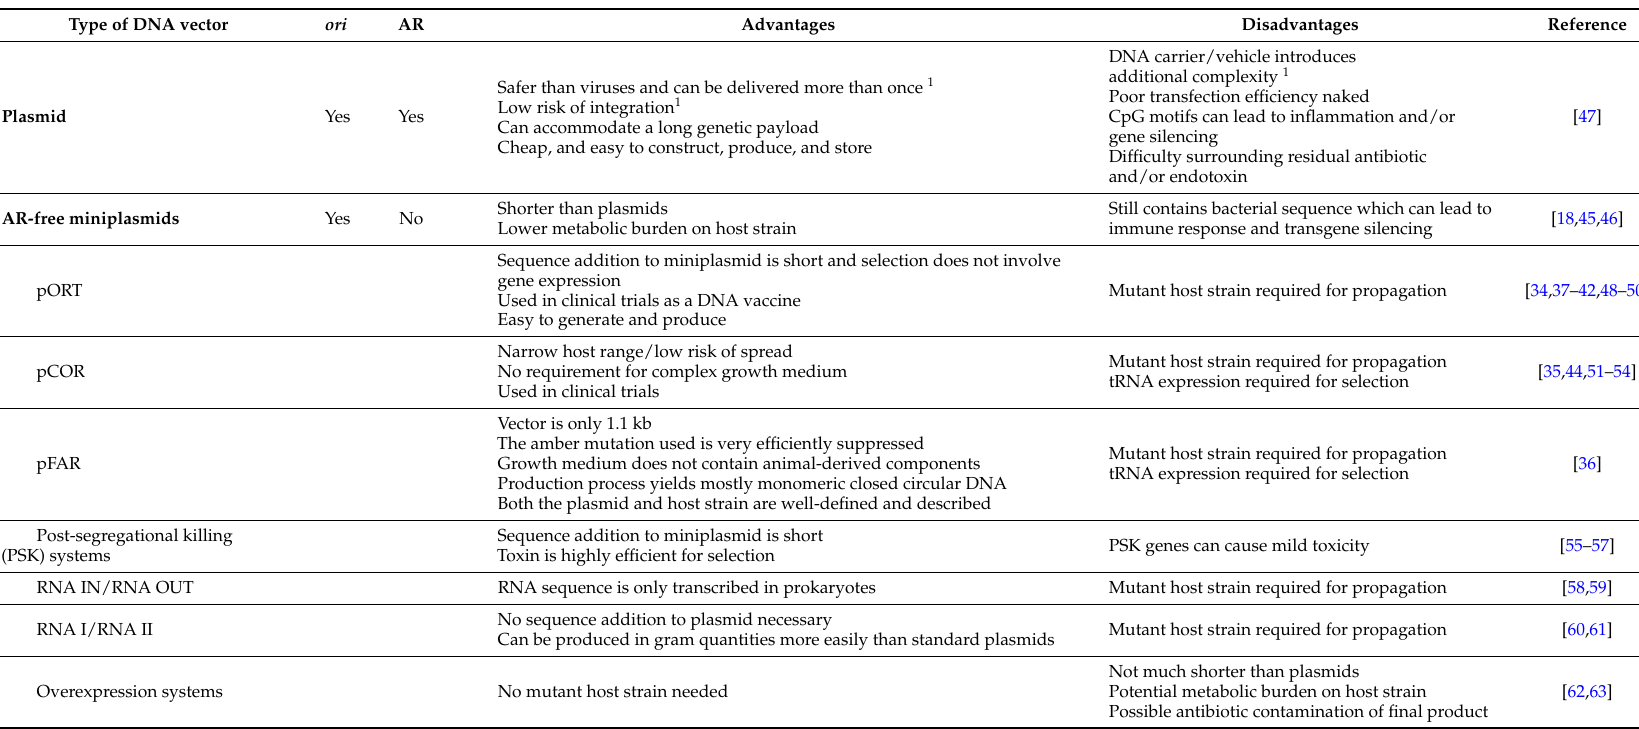
Table 2. Vector production and gene therapy advantages and disadvantages of non-viral DNA vectors, with special emphasis on minimized vector systems. Type of DNA